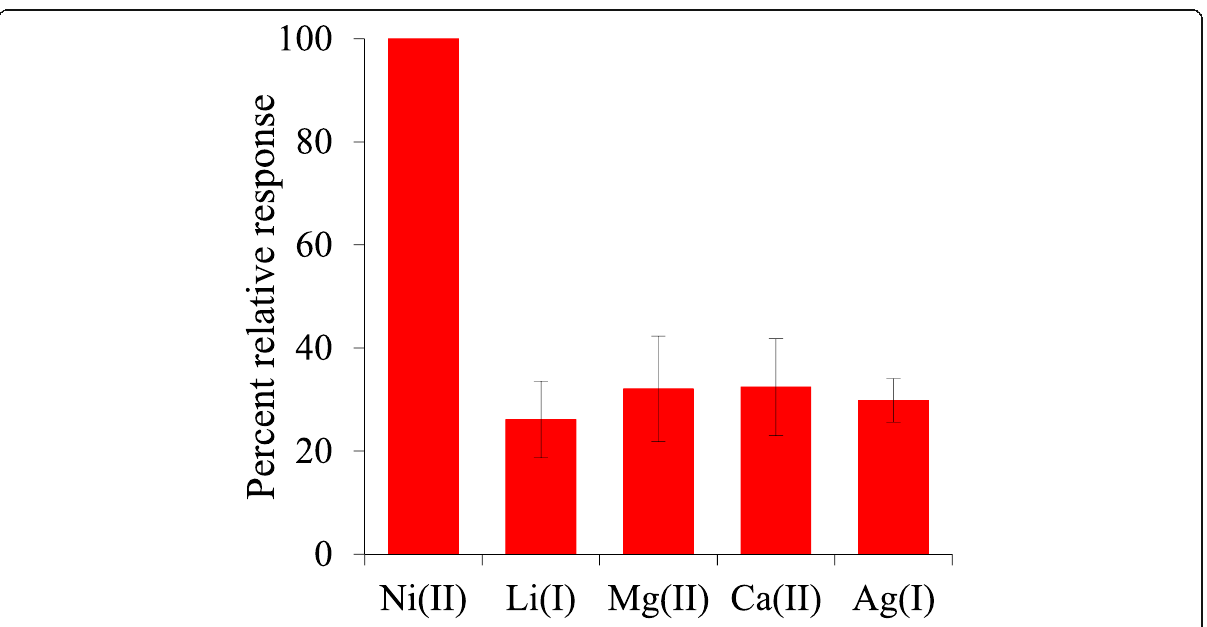
Fig. 9 Relative responses of metal ions of less than 35% indicating assay preference for Ni 2+